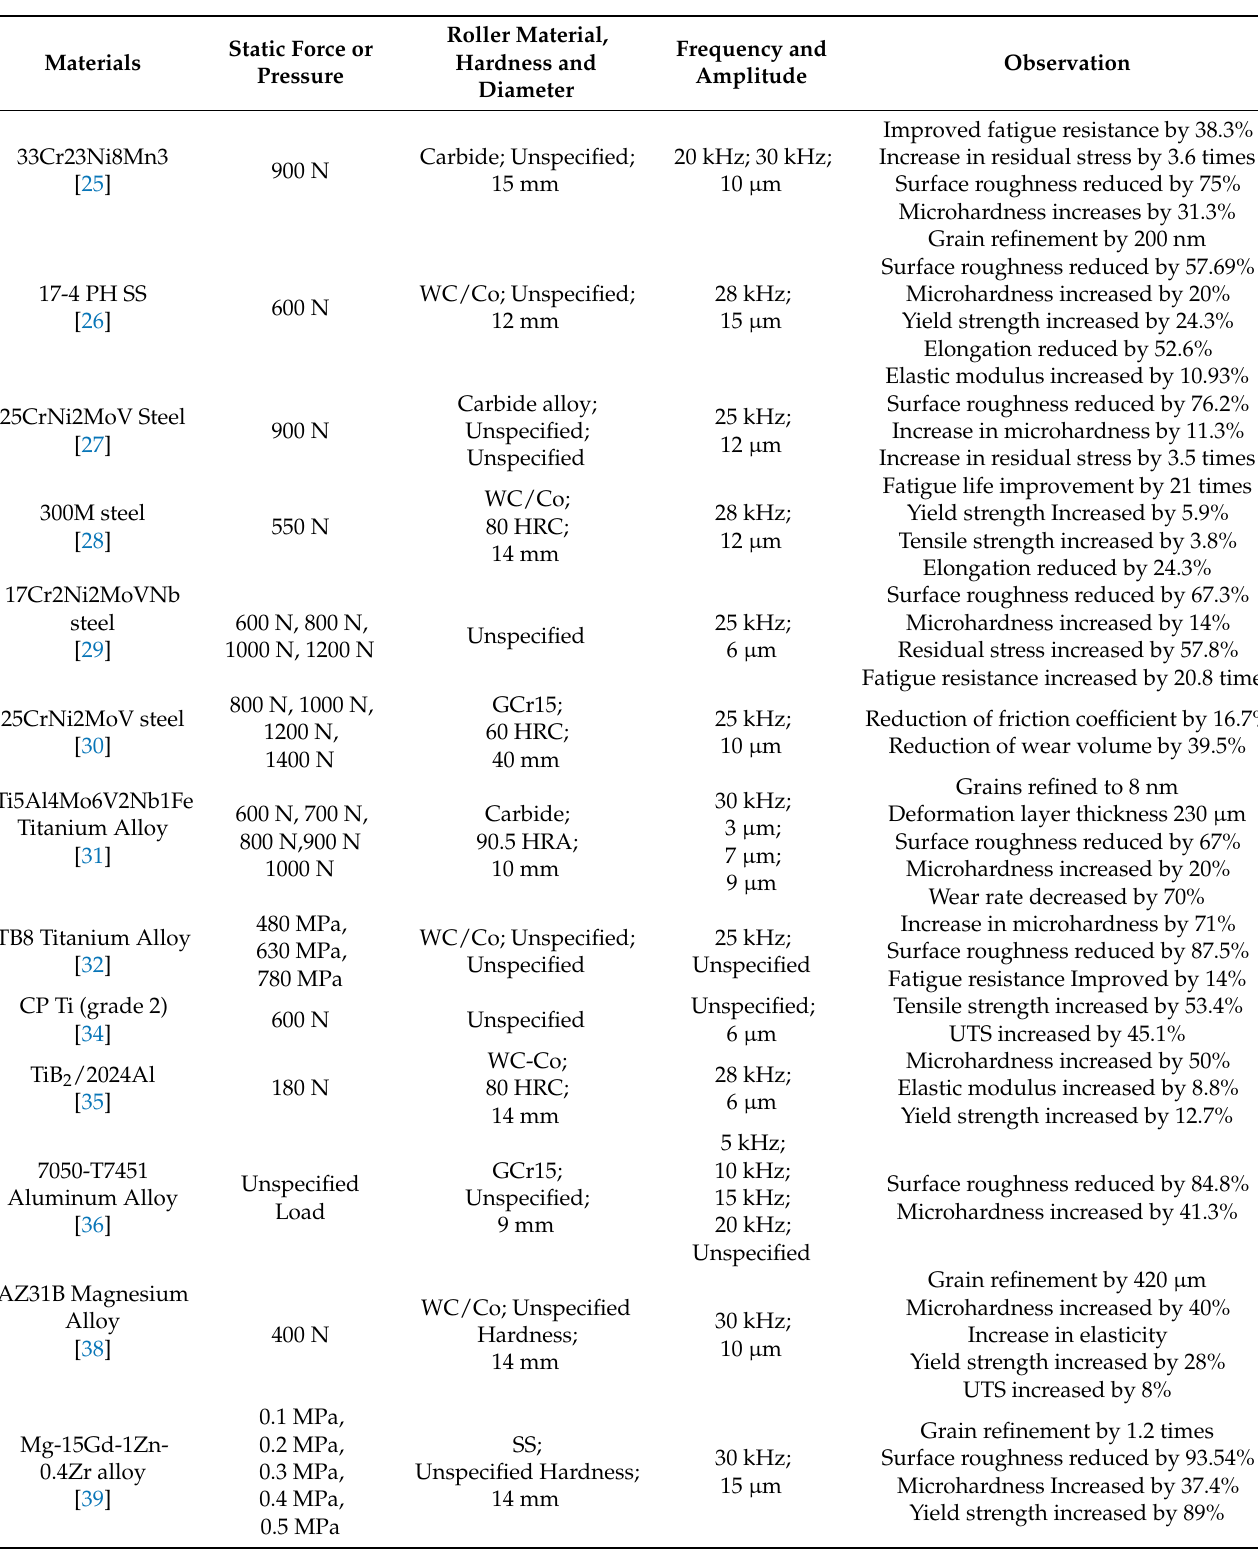
Table 1. Effect of USRP on various engineering